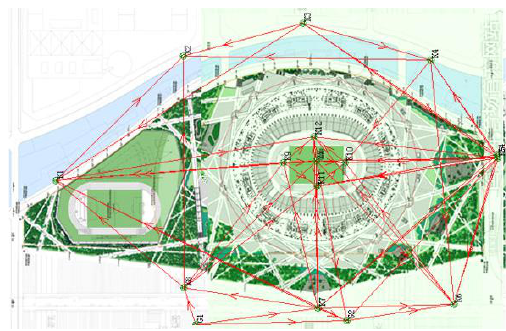
Figure 10 point cloud of five frames